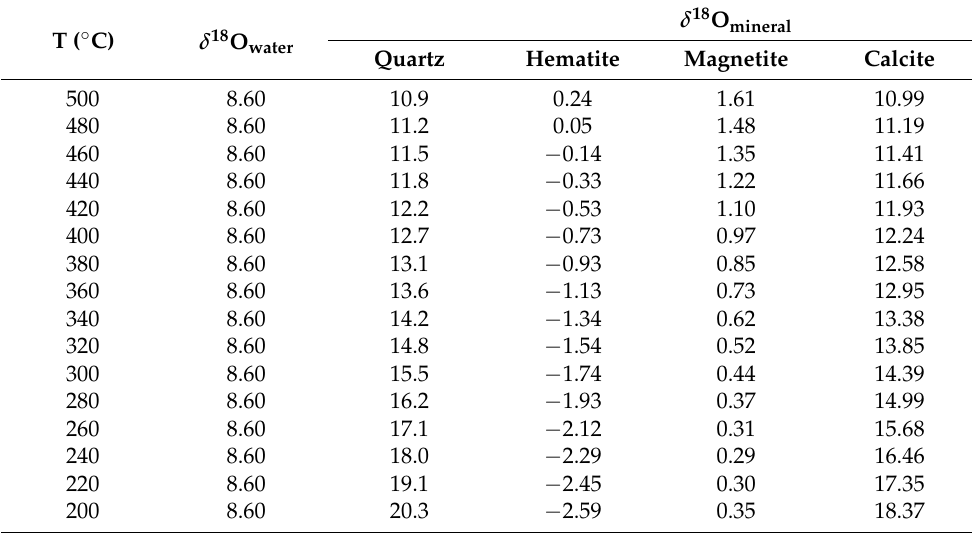
Table 3. Calculated oxygen isotope compositions of quartz, hematite, magnetite, and calcite in the boiling model, in equilibrium with a magmatic brine ( T = 500 ◦ C, δ 18 O = 8.6 ) that is progres- (cid:104) sively cooling. δ 18 O mineral T ( ◦ C) δ 18 O water Quartz Hematite Magnetite